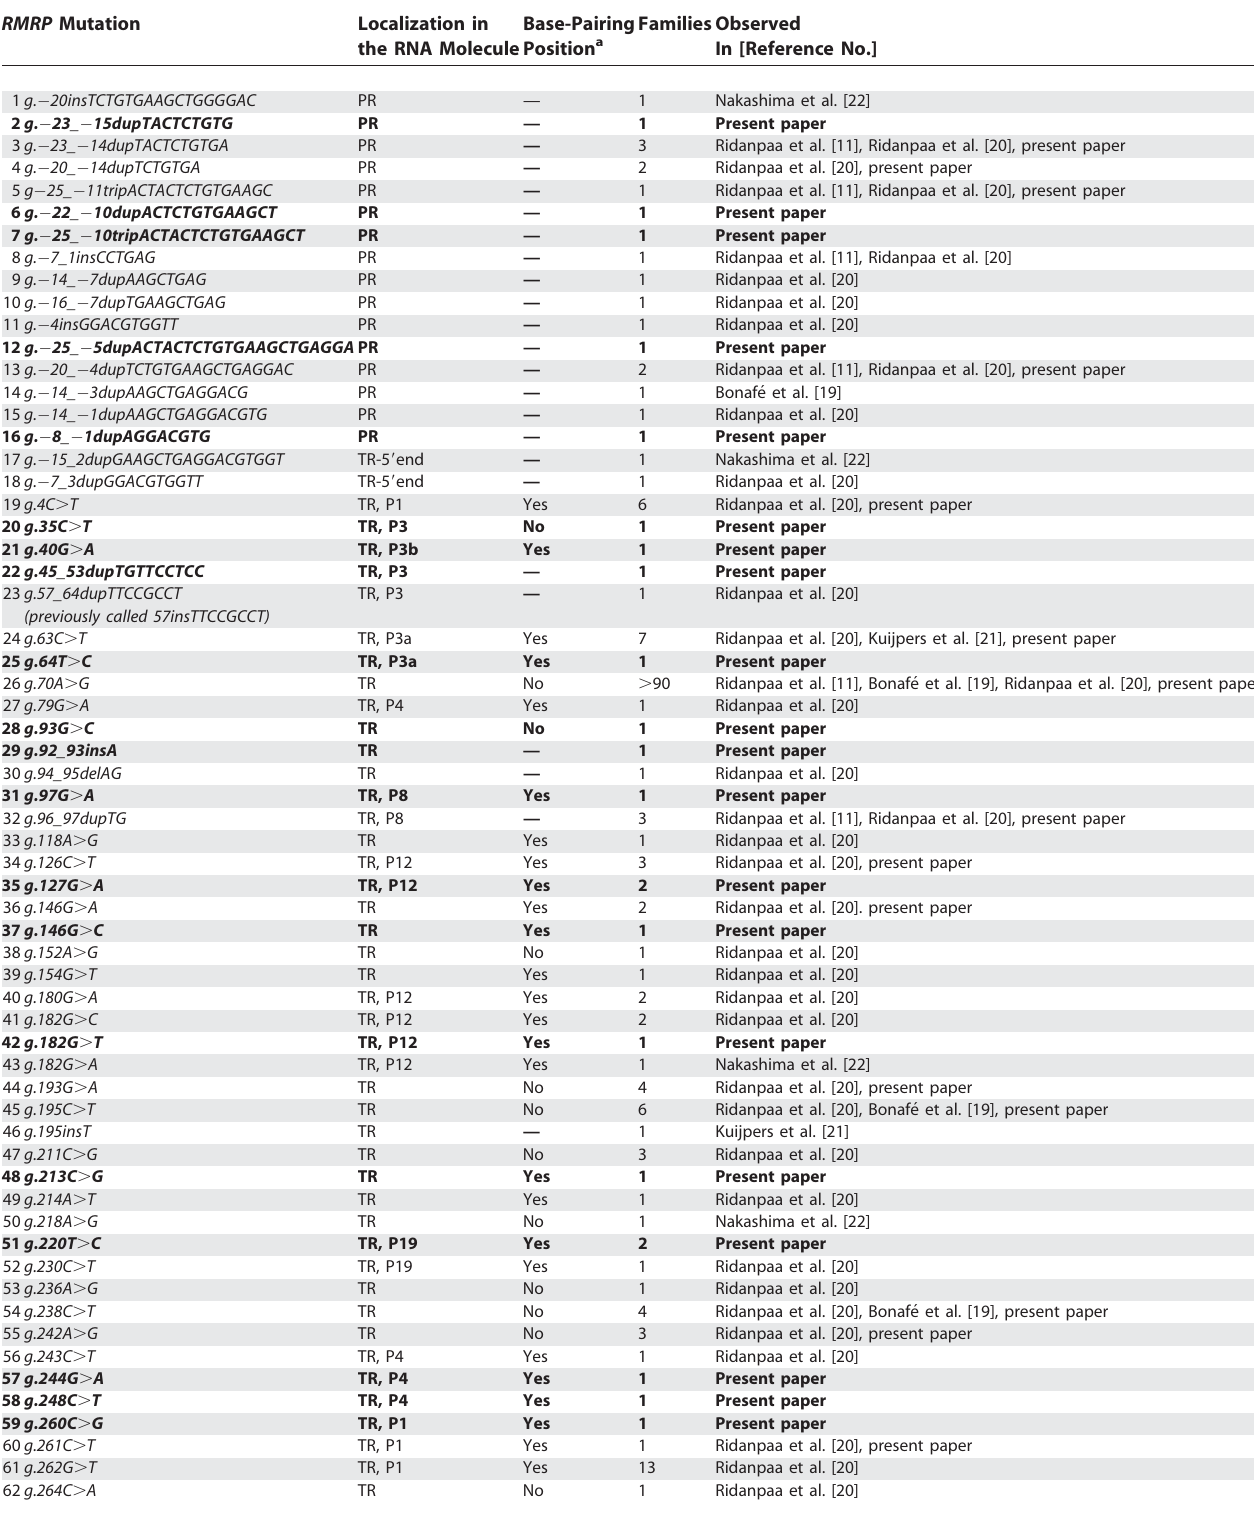
Table 2. RMRP Variants: 20 New Putative Pathogenic Mutations and Review of Reported Mutations RMRP Mutation Localization in MoleculeBase-Pairing the RNA Position a